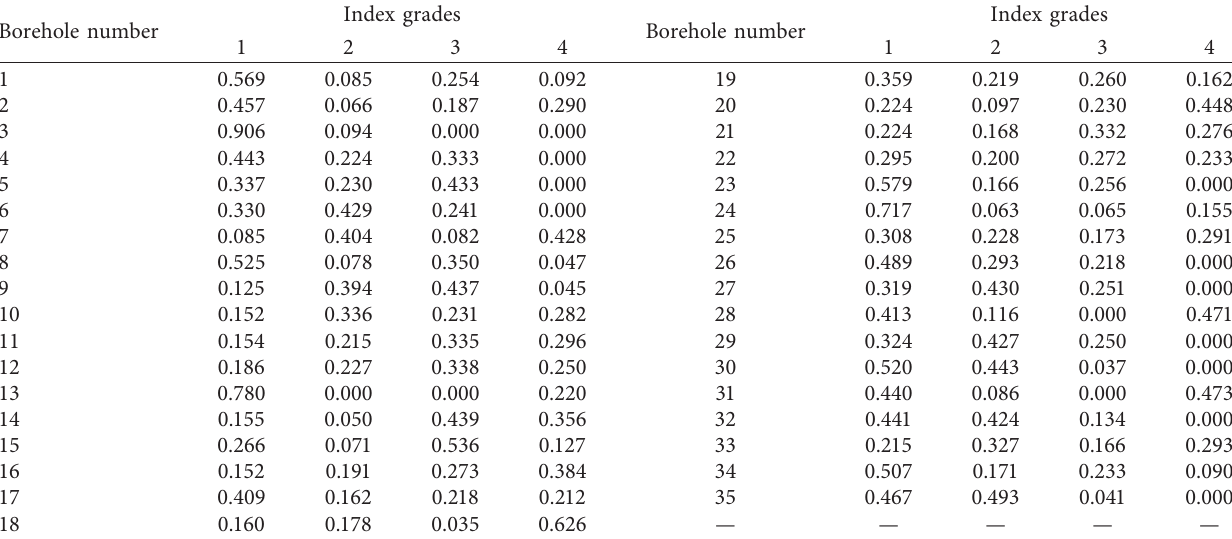
Table 6: The multi-index comprehensive unascertained measure.